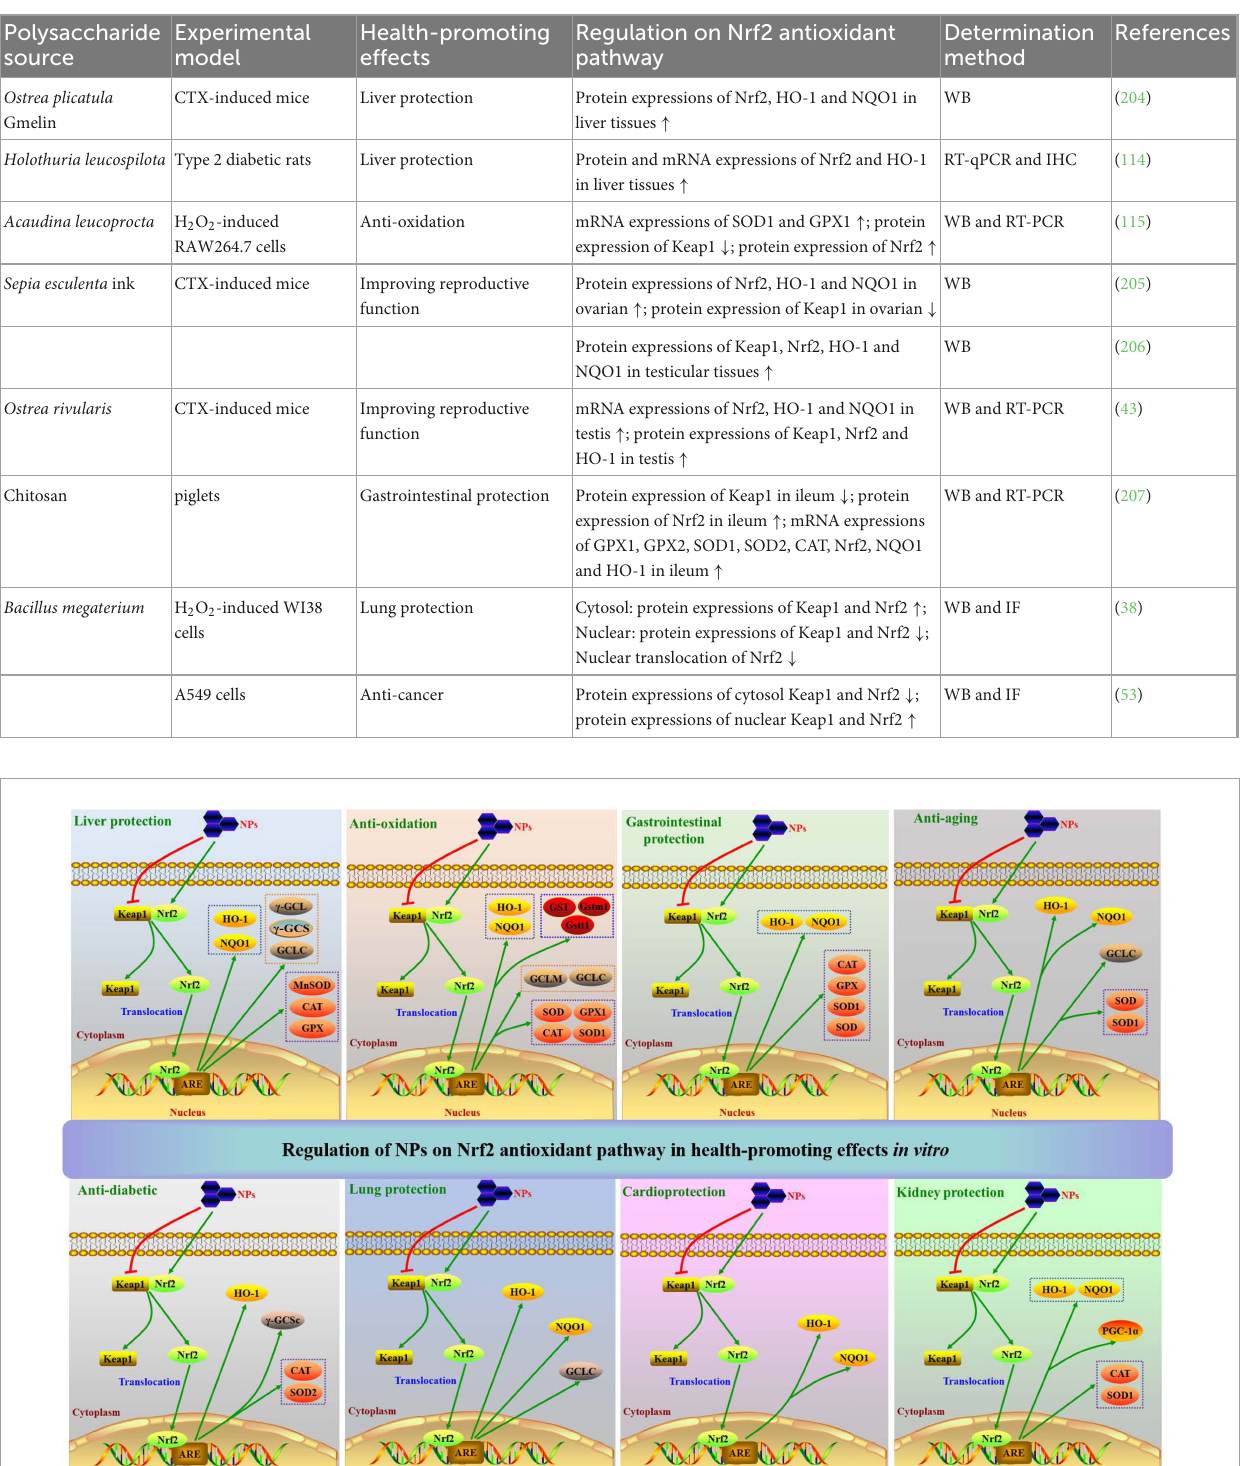
TABLE 5 Regulation of NPs from animals and bacteria on Nrf2 antioxidant pathway for health-promoting effects.